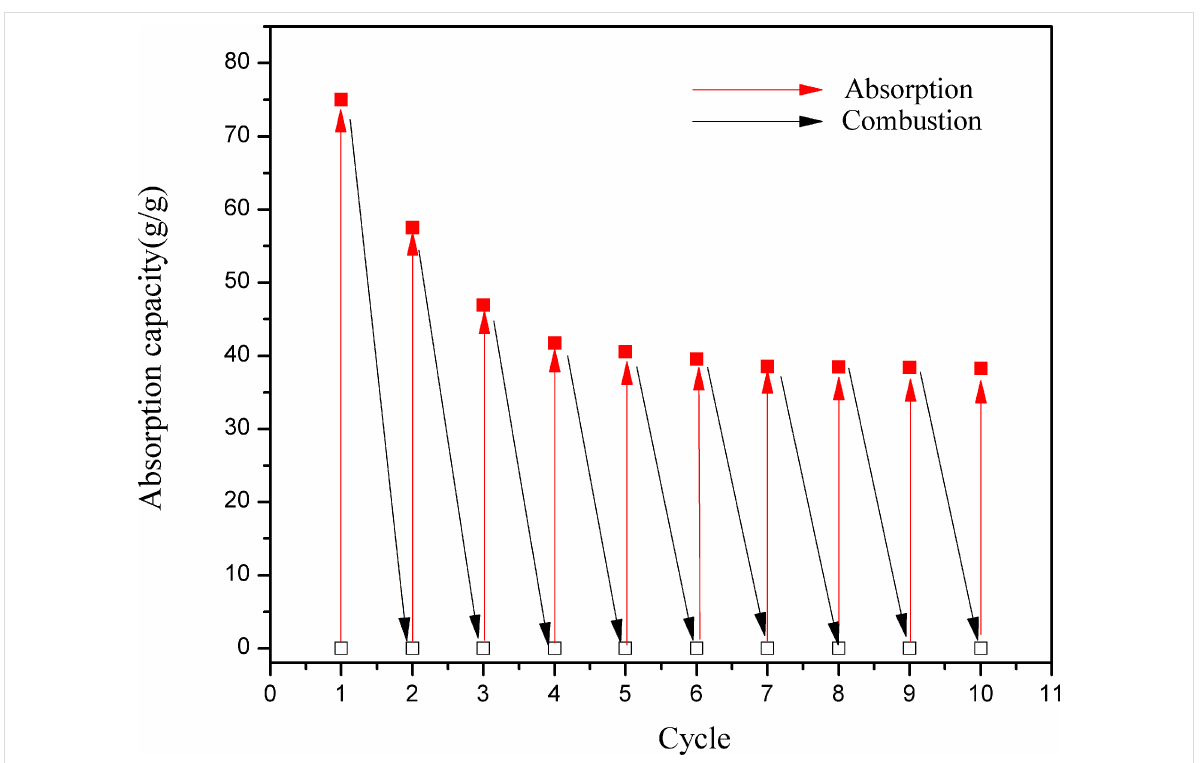
Figure 10: Recycling performance of CNF/PVA/GO carbon aerogels for absorption of soybean oil by absorption/combustion processes.